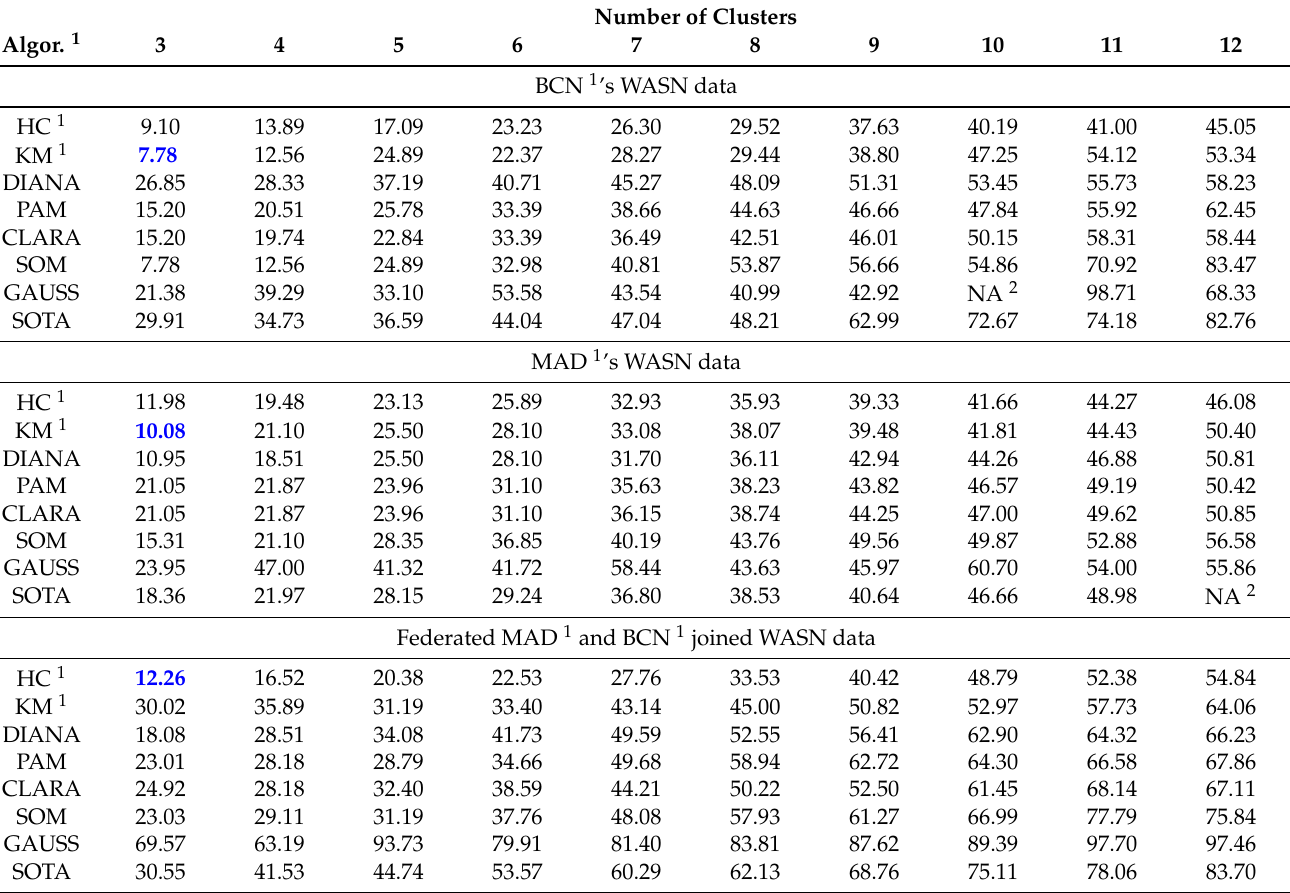
Table 3. Evaluation and comparison of clustering techniques over WASN data based on the Connec- tivity